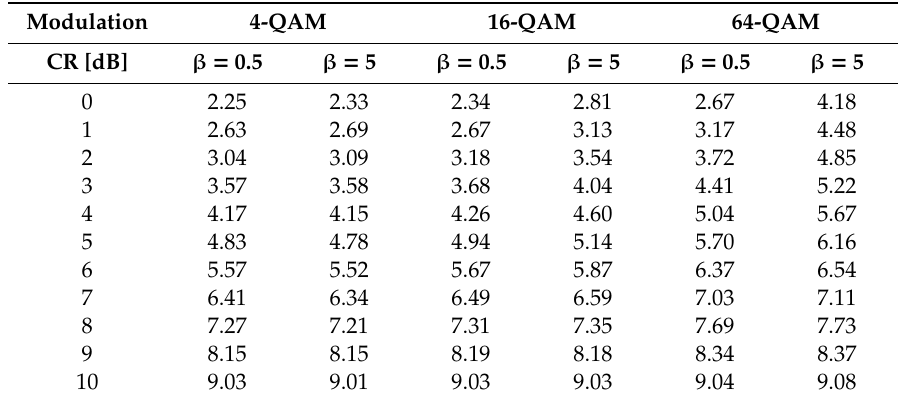
Table 2. CCDF = 10 − 4 for the proposed method for β = 0.5 and β = 5 with variable modulation and CRs. Modulation